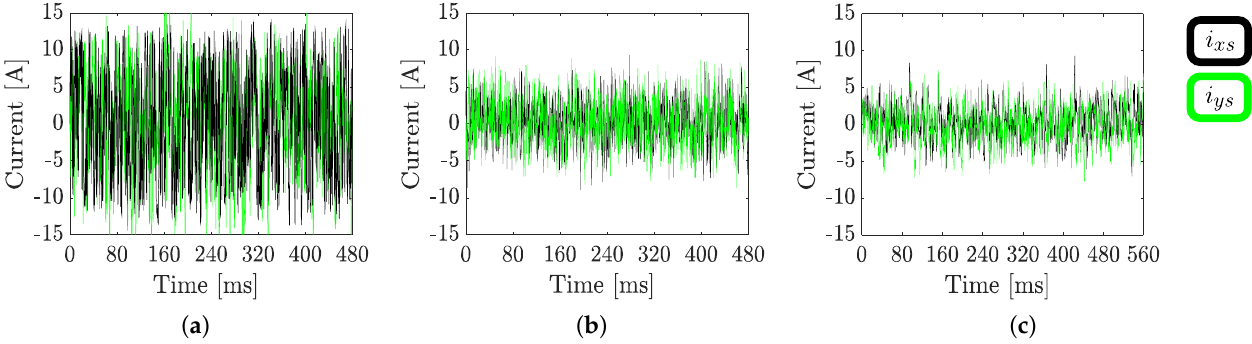
Figure 9. Performance of stator currents in x – y plane for a rotor speed of 200 (rpm) at 2.5 (kHz) of sampling